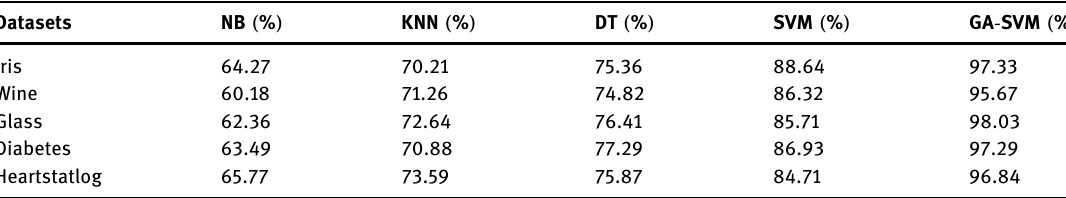
Table 4: Comparison of accuracy between di ff erent machine learning algorithms